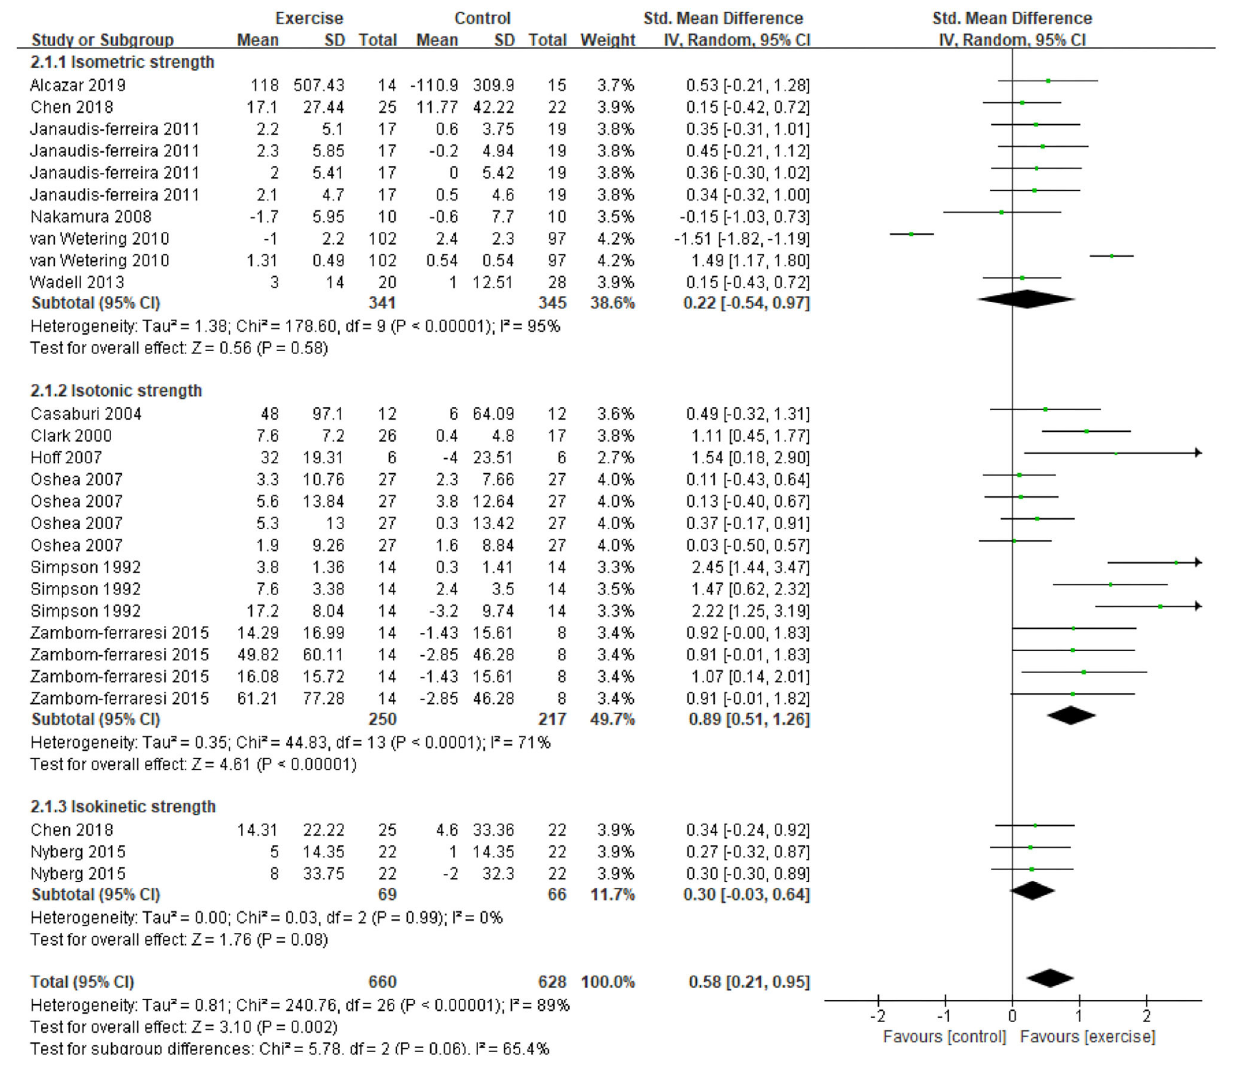
study still confirmed the significant positive effect of exercise on improving peripheral skeletal muscle strength in stable